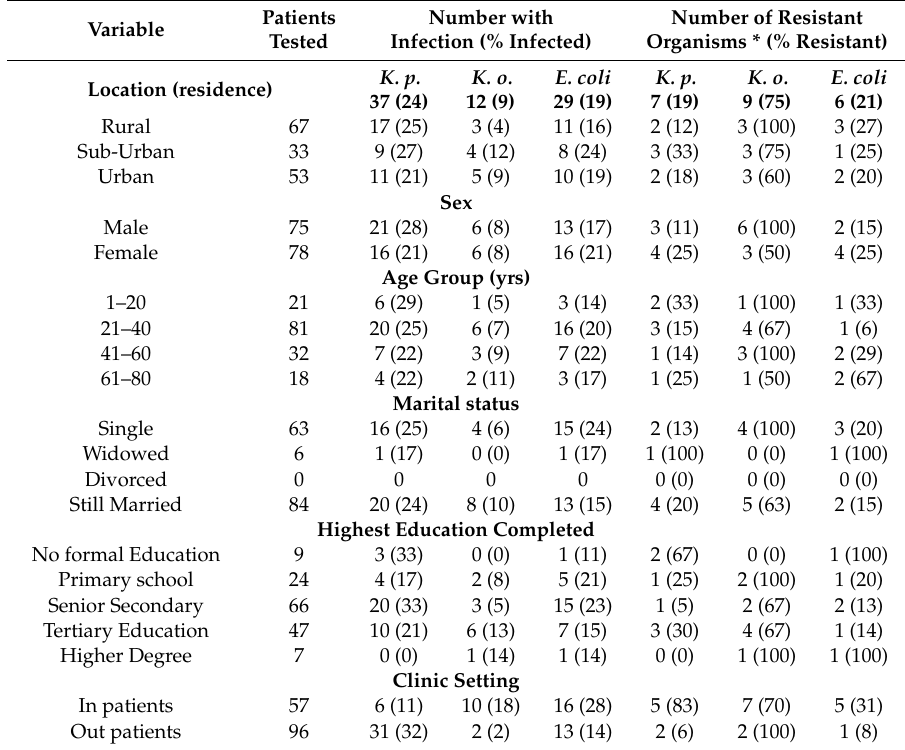
Table 1. Prevalence of the enterobacteriaceae isolated (Total number of Samples N =